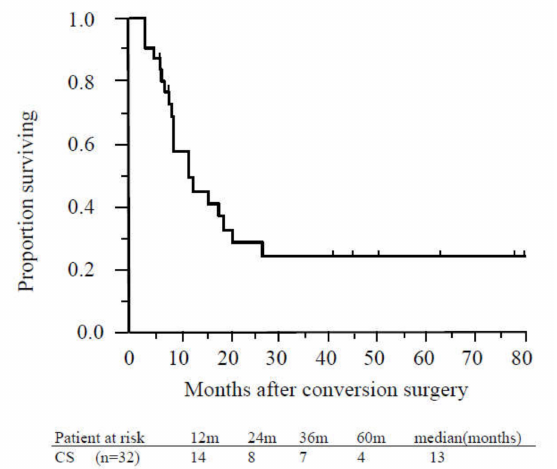
Figure 4. Recurrence-free survival of patients who underwent conversion surgery. The median recurrence-free survival time of patients who underwent conversion surgery was 13 months. Abbreviations: CS, conversion surgery.